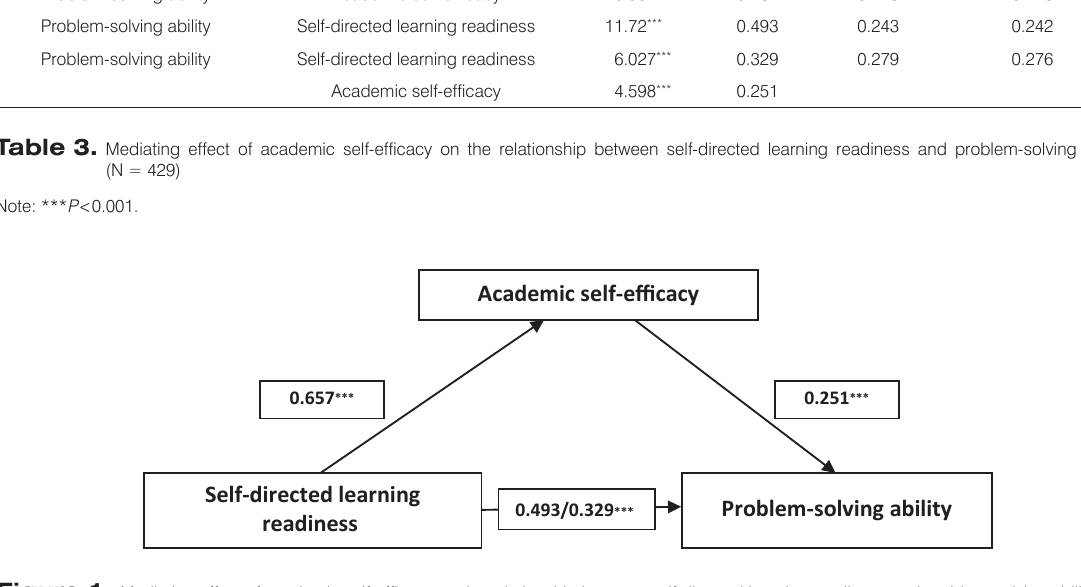
Figure 1. Mediating effect of academic self-efficacy on the relationship between self-directed learning readiness and problem-solving ability. Note: *** P <